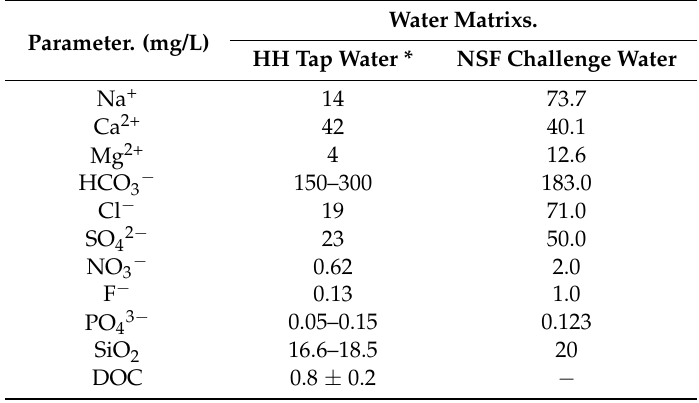
Table 2. Water quality parameters of Hamburg tap water (* data obtained from Hamburgwasser) and NSF challenge